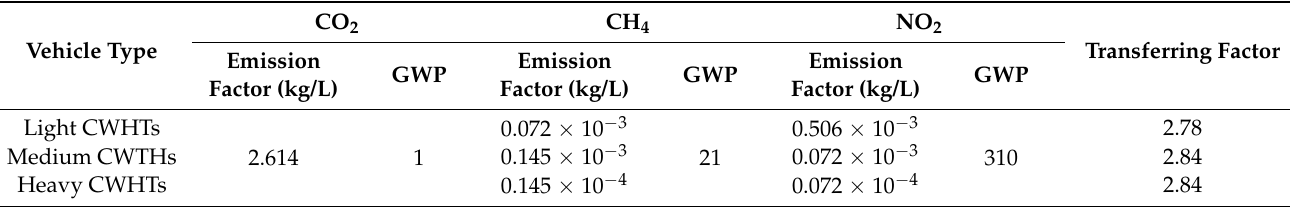
Table 5. Detailed parameters for calculating carbon